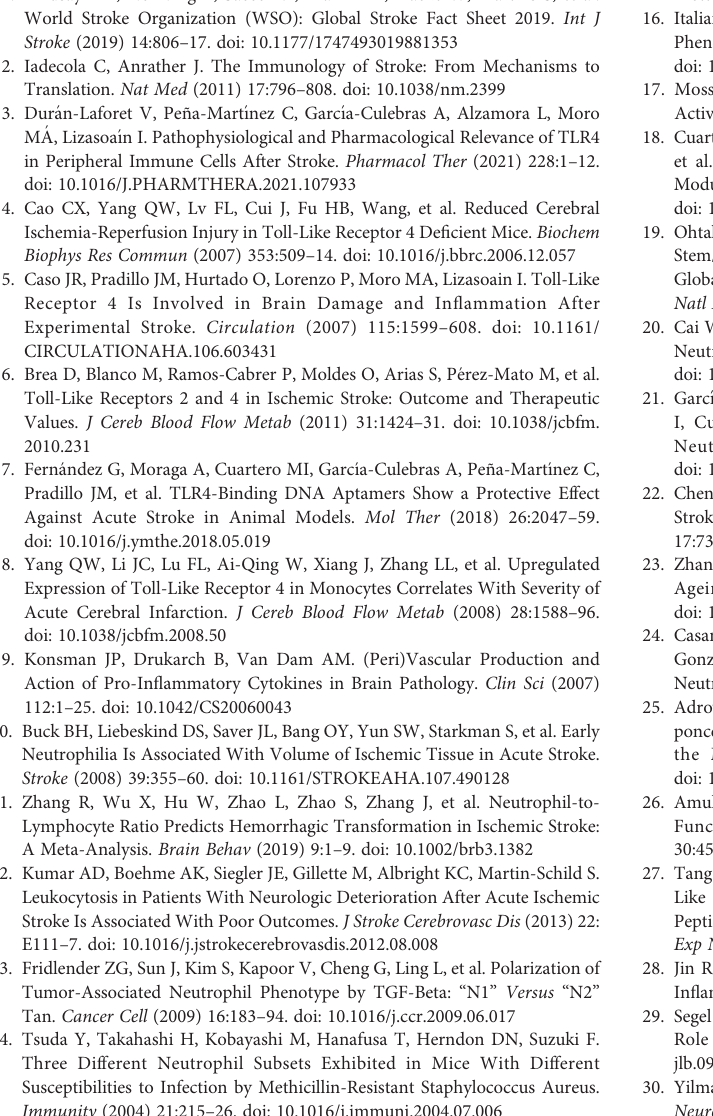
from MRI images (Magenta: ipsilateral hemisphere; Yellow: contralateral hemisphere; Red: infarct). Data are mean ± SEM. Supplementary Figure 2 | Microglia engulfment colocalization analysis. (A) Representative images used for the colocalization analysis of the different channels two by two (green vs red, green vs blue and blue vs red). (B) Table containing the different values obtained with the colocalization analysis tool (Zen software, Zeiss). (C) Orthogonal projection of the representative microglia cell used to calculate the colocalization parameters (Green: Iba1, blue: NIMP-R14, red: Ym1). Supplementary Figure 3 | Apoptosis assay in blood neutrophils. Two-way ANOVA analysis of the data showing a signi fi cative effect of time in both genotypes (Time: P<0.05, F[2, 10] 6.536; (*P < 0.05 vs TLR4 loxP/loxP pre-surgery; #P < 0.05 vs TLR4 loxP/Lyz-cre pre-surgery; $P<0.05 vs TLR4 loxP/Lyz-cre 24h;P=0.05TLR4 loxP/loxP 48 h vs TLR4 loxP/loxP 24 h; n=5). Data are mean ± SEM.